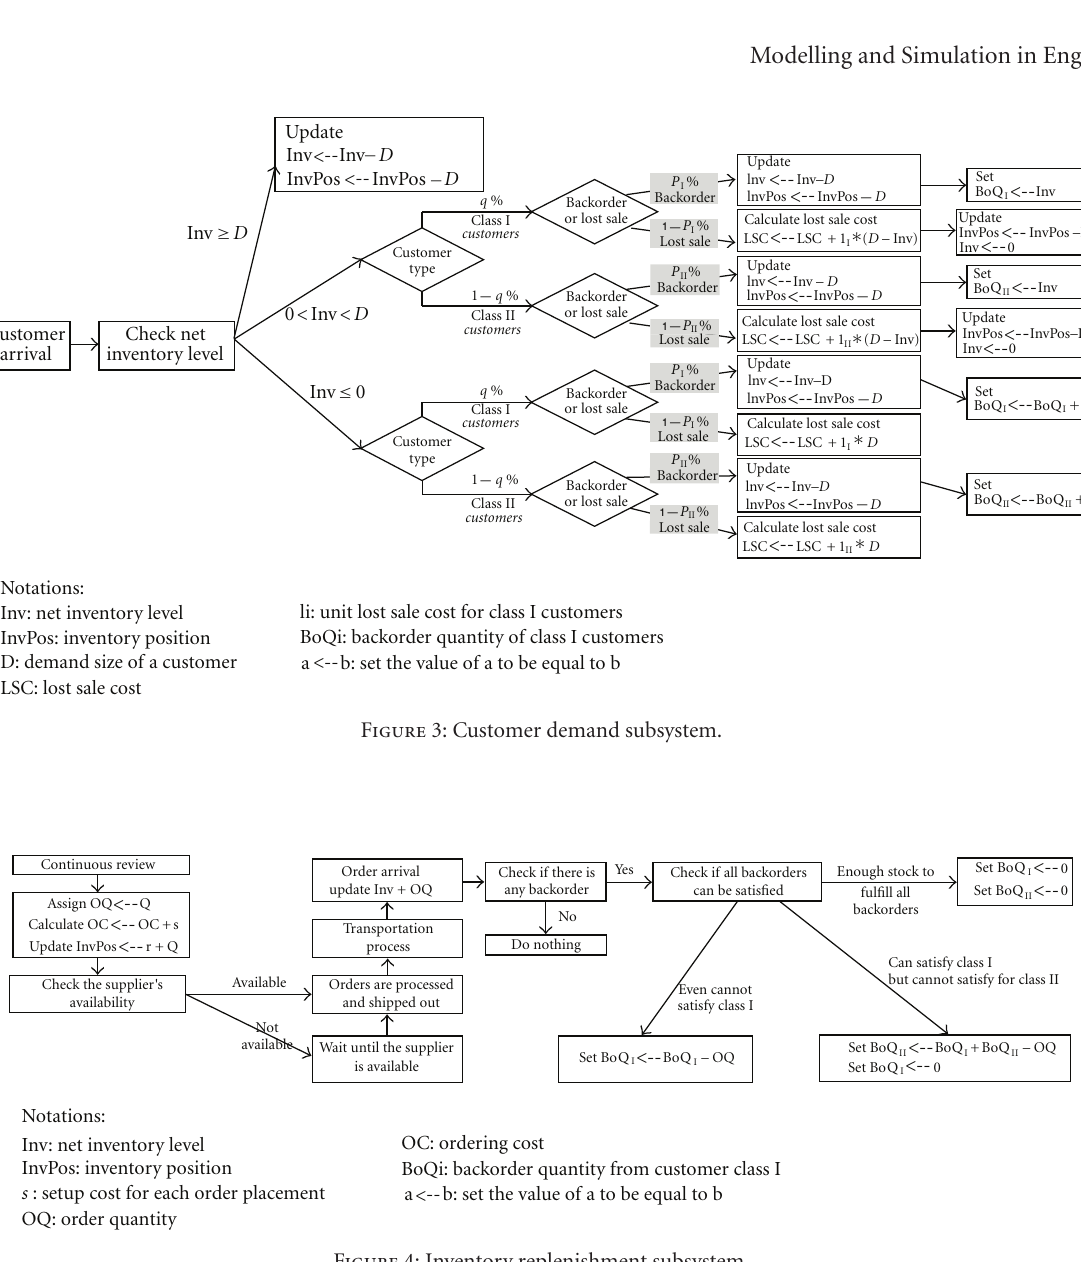
Figure 4: Inventory replenishment